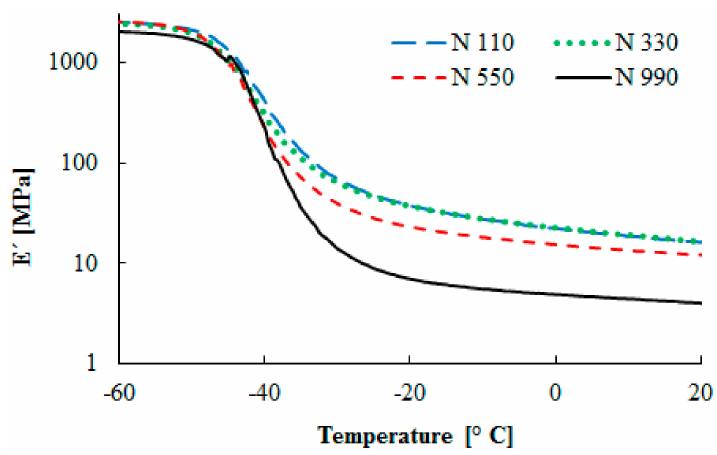
Figure 3. Temperature dependence of the tensile storage modulus.